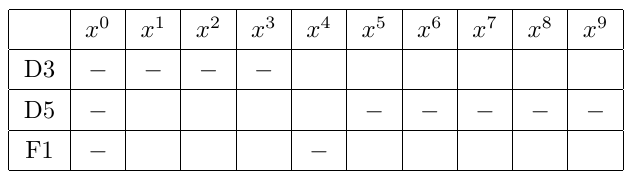
Figure 2 . Array of M D5-branes with ( m 1 , m 2 , . . . m M ) F1-strings stretched between them and the N D3-branes. Note that even if the branes are separated for illustration purposes they are actually coincident.